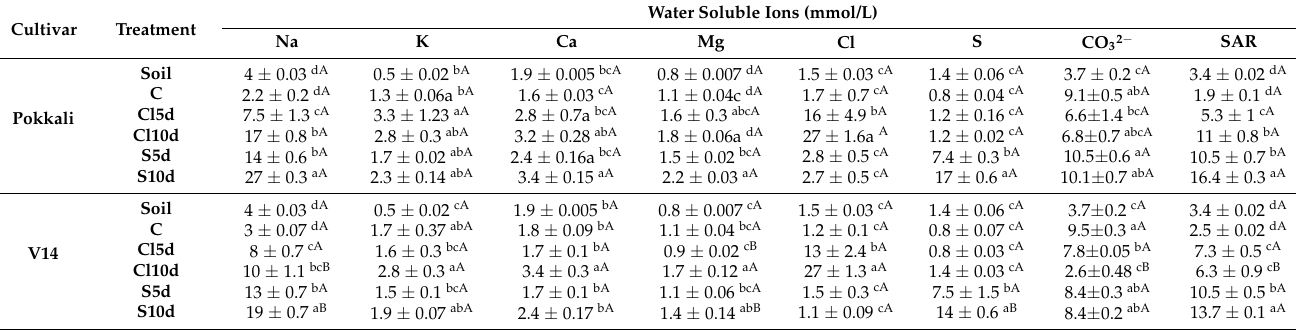
Table 3. Water-soluble ions content and sodium adsorption ratio (SAR) of uncultivated and unsalted soil (Soil), unsalted soil cultivated with control plants (C) and cultivated soil salinized by 5 dS m − 1 (5d) or 10 dS m − 1 (10d) of NaCl (Cl) or Na 2 SO 4 (S). Plants belong to two distinct cultivars (Pokkali: salt-resistant and V14: salt-sensitive). Parameters were recorded after plant